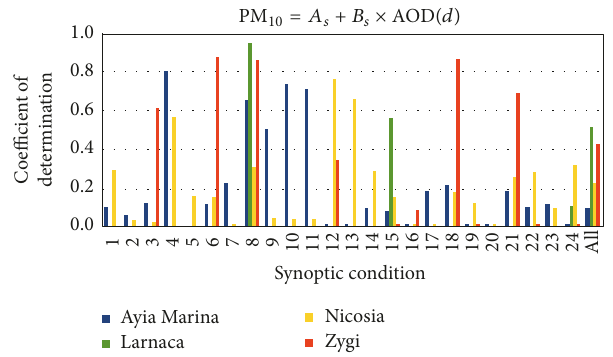
Figure 10: Coefficient of determination for the simple linear model for the Ayia Marina, Larnaca, Nicosia, and Zygi stations. It is shown separately for each of the synoptic conditions (1–24) and for all cases irrespective of the prevailing synoptic condition (shown as All).